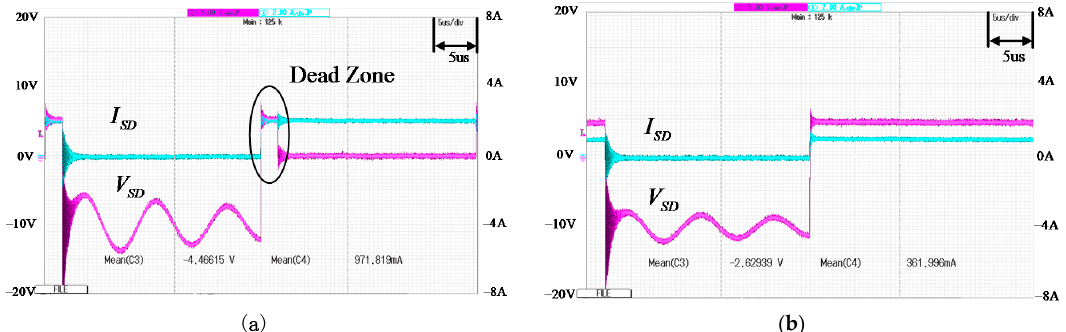
Figure 4 . Freewheeling waveforms: ( a ) Figure 4. Freewheeling waveforms: ( a ) V